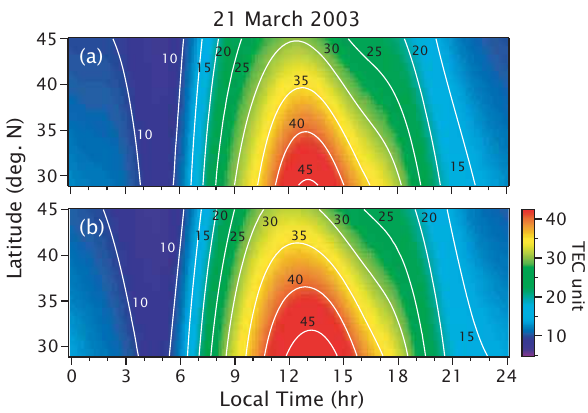
Fig. 7. Same as Fig. 5 but for September equinox 2003.